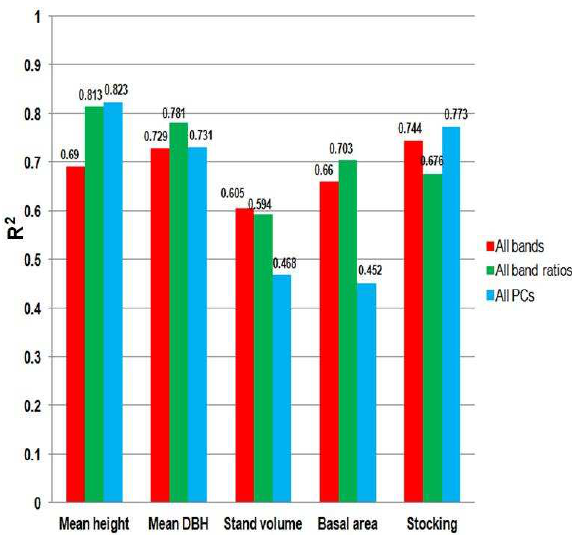
Figure 3. The R 2 results of textural attributes derived from SPOT-5 spectral